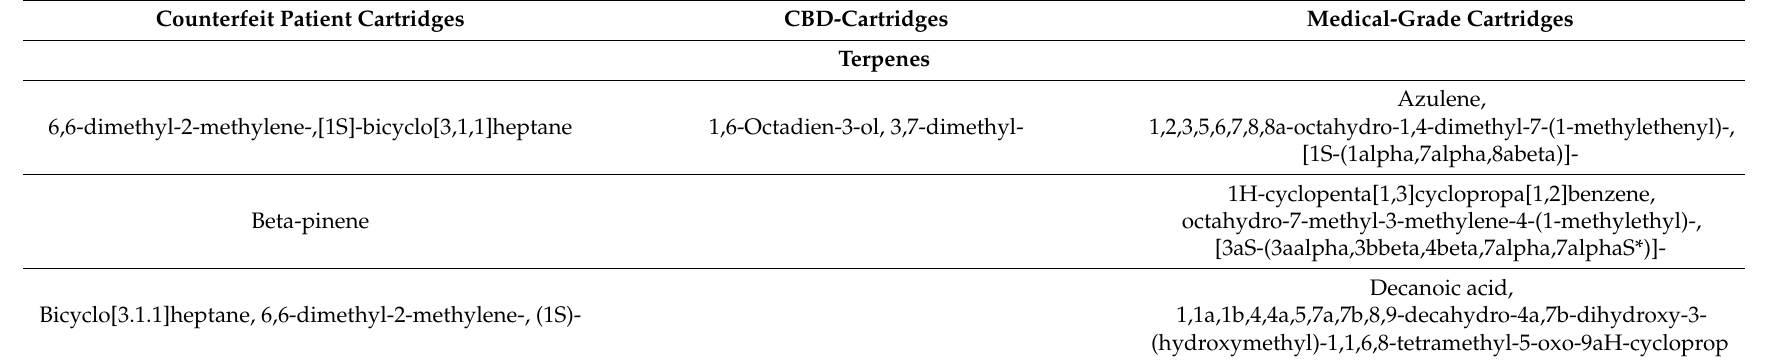
Table 1. Commonly present constituents in counterfeit, CBD, and medical-grade